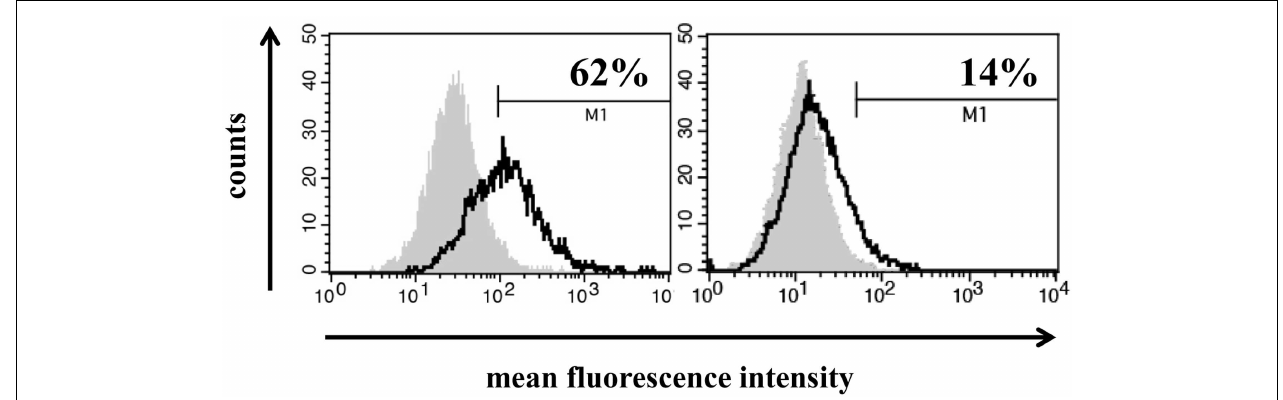
surface of tumor cells.The white histogram represents the HSP70 membrane staining of the tumor cells and the gray histogram the staining with a negative control FITC-conjugated isotype-matched control antibody. The percentage of HSP70 membrane-positive cells was corrected by subtraction of the isotype control.